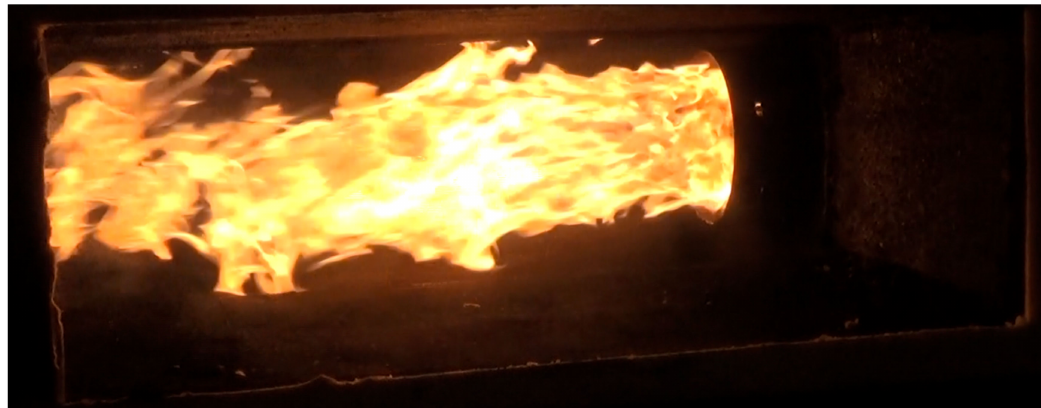
Figure 4. Flame shape in